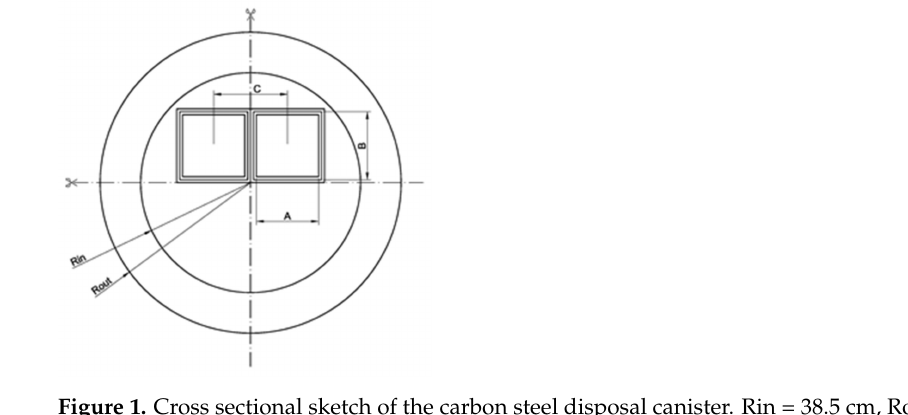
Figure 1. Cross sectional sketch of the carbon steel disposal canister. Rin = 38.5 cm, Rout = 52.5 cm, A ≈ 21.5 cm (side of the FA top head), B = 23.5 cm (inner dimension of the FA box), C = 25.5 cm (box center-to-center